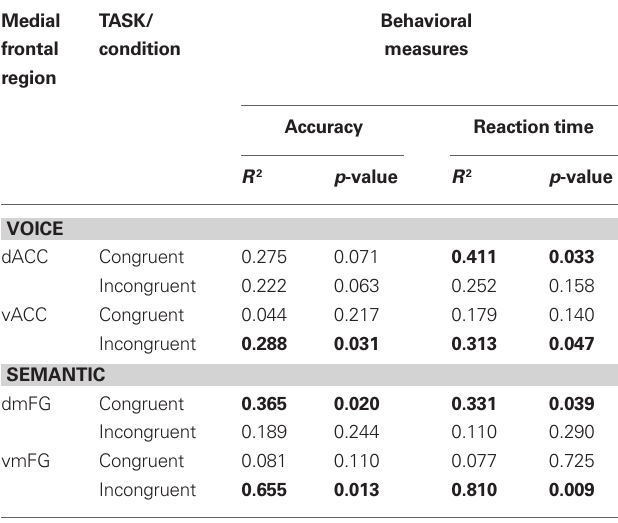
Group-averaged data showing peak intensity values and coordinates (mm in Talairach space) for activated clusters (Brodmann areas in parentheses). Activation threshold = p < 0.01 (corrected), N = 26, and volume is in mm 3 . An interference effect common to both tasks was found in left anterior insula ( bold ). (a) Activation extends into left claustrum and putamen. (b) Activation extends into right anterior insula. Table 3 | Linear regression analysis of peak BOLD activity in medial frontal clusters vs. behavioral responsiveness in the two auditory Stroop